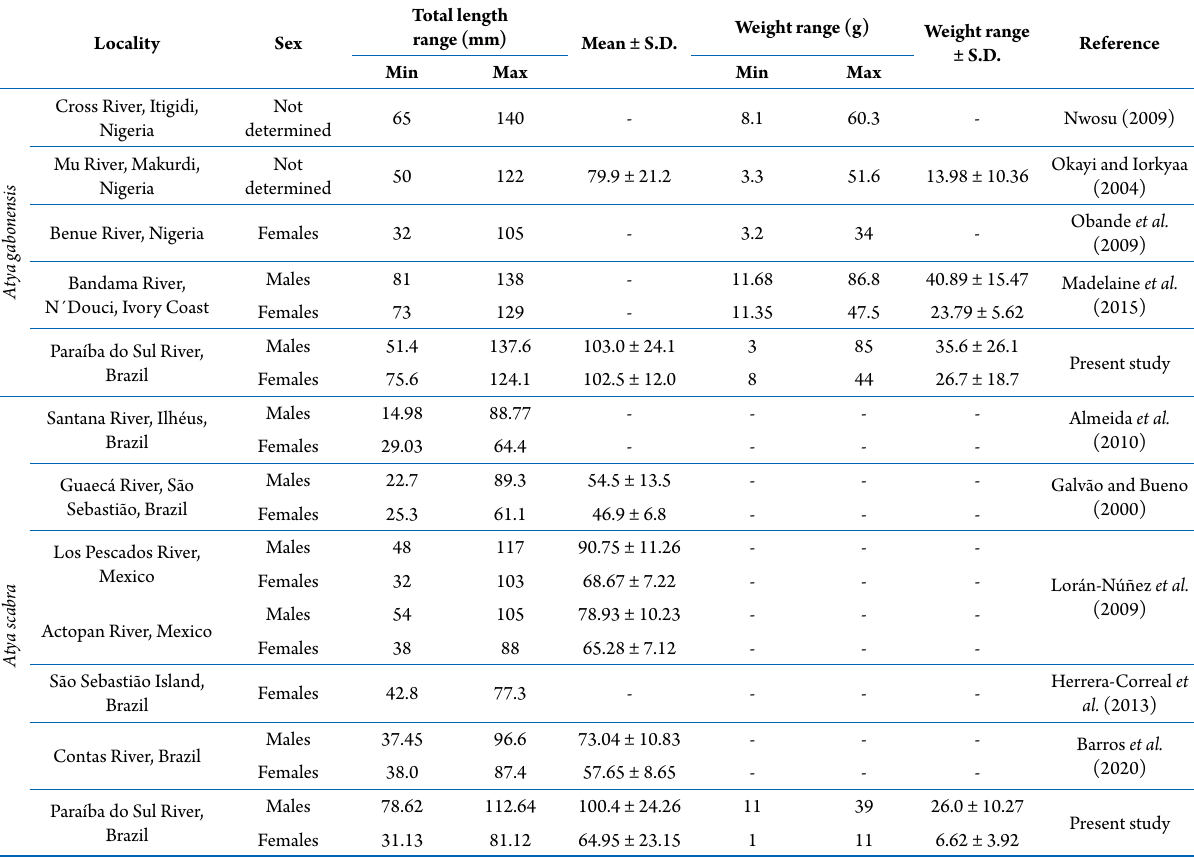
Table 5. Minimum, maximum and mean values ± standard deviation of total length (mm) and weight (g) of Atya gabonensis Giebel, 1875 and Atya scabra (Leach, 1816), obtained in different locations, available in previous studies and the present study. Total length range (mm) Mean ± Locality Sex